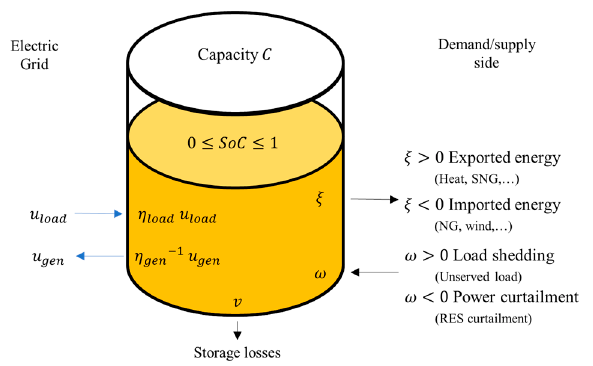
Figure 4. Modified power node model scheme.